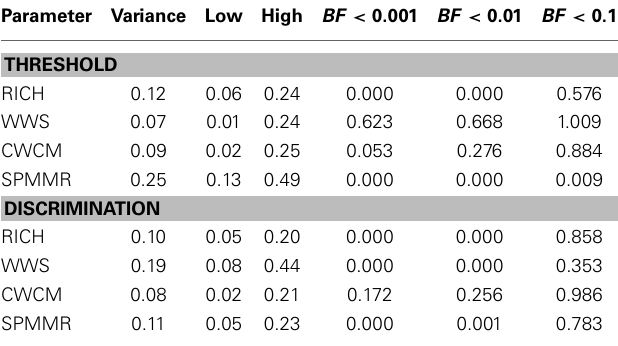
Table 2 | Test of measurement invariance for item parameters.